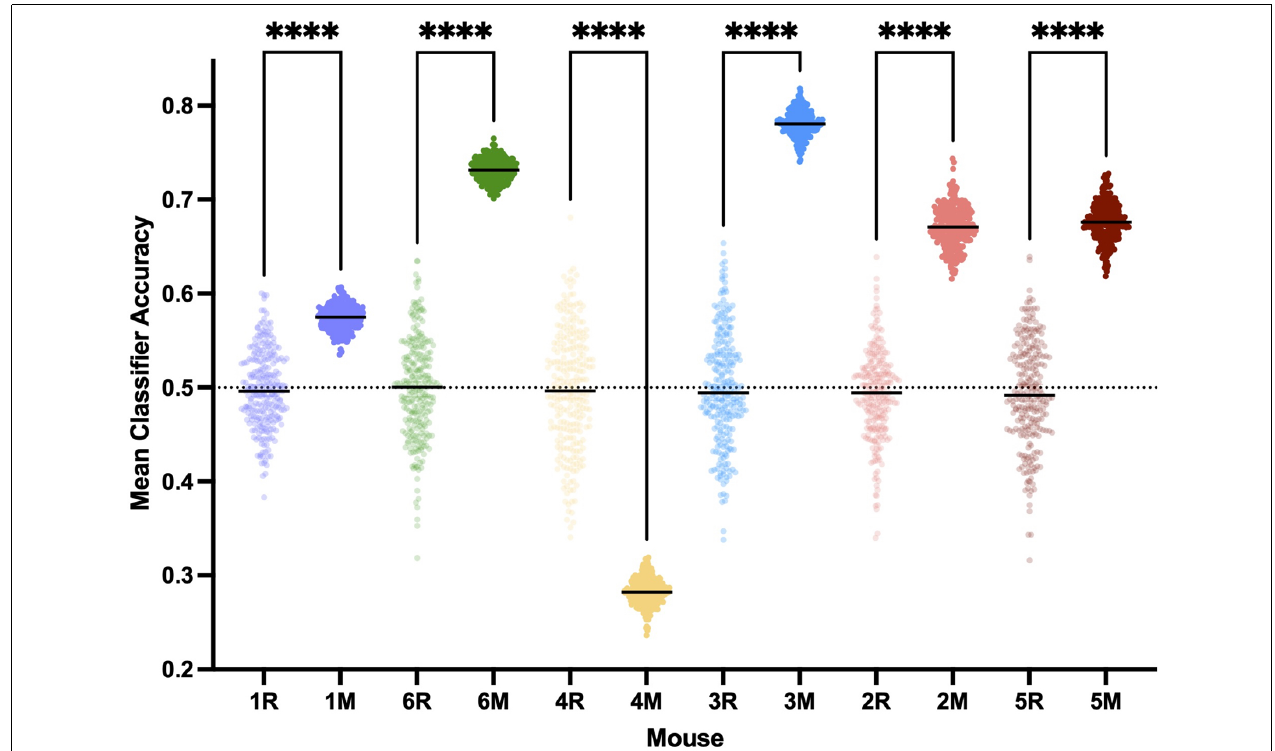
FIGURE 9 | Classifying by population spectra detects individual neural inertia less efficiently than individualized classification. Training linear classifiers on population data resulted in classifier accuracy greater than chance ( p < 0.0001, Kruskal-Wallis) and thus evidence for neural inertia in five of the six mice, rather than detecting neural inertia in all mice 6 with individualized training sets. **** p <